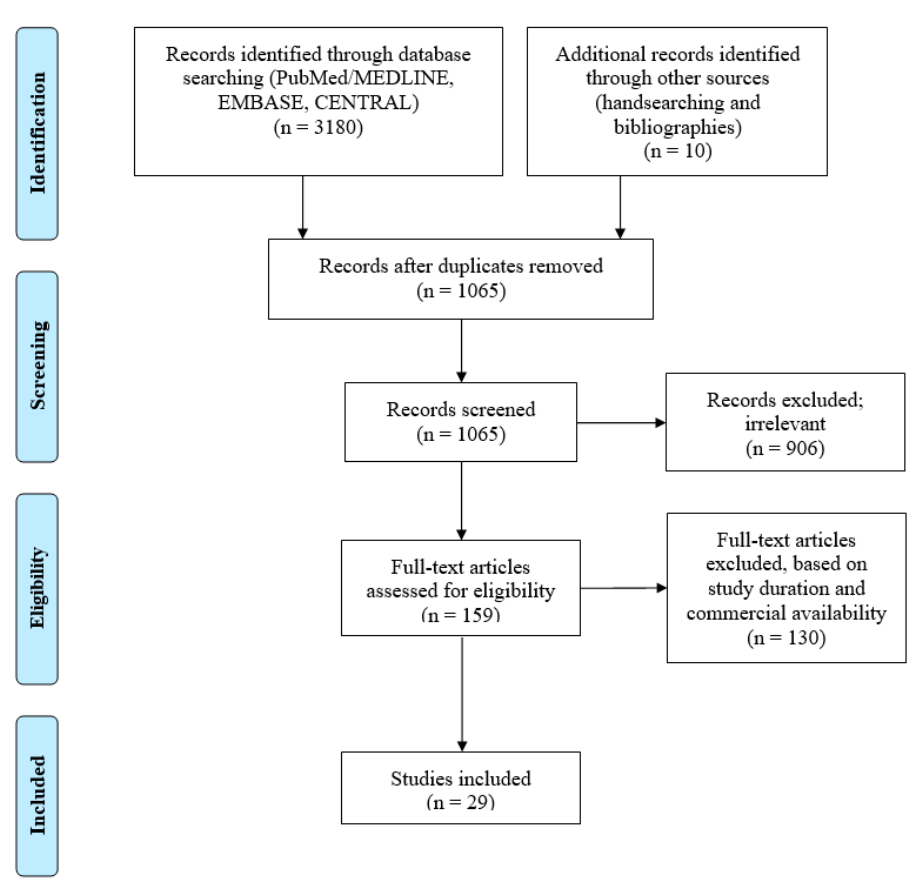
Figure 2. PRISMA (preferred reporting items for systematic reviews and meta-analyses) flow diagram.